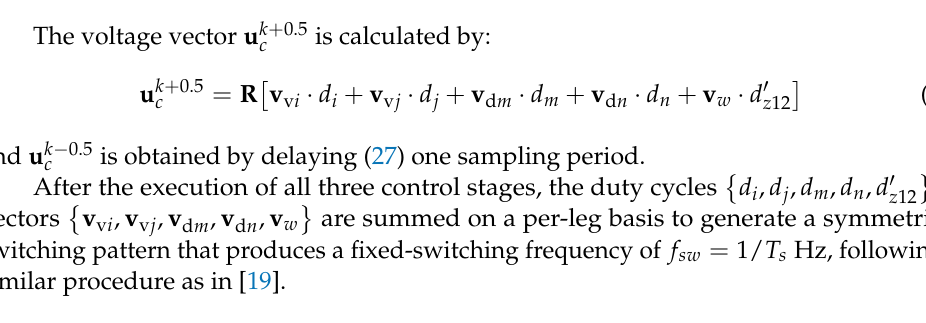
Figure 4. Flowchart of the proposed fault-tolerant control strategy.